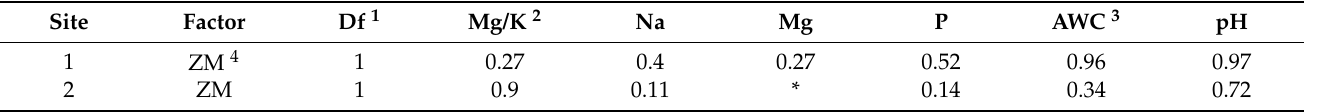
Table 8. Results of the ANOVA applied to the soil samples based on the zone management experi- mental factor for both